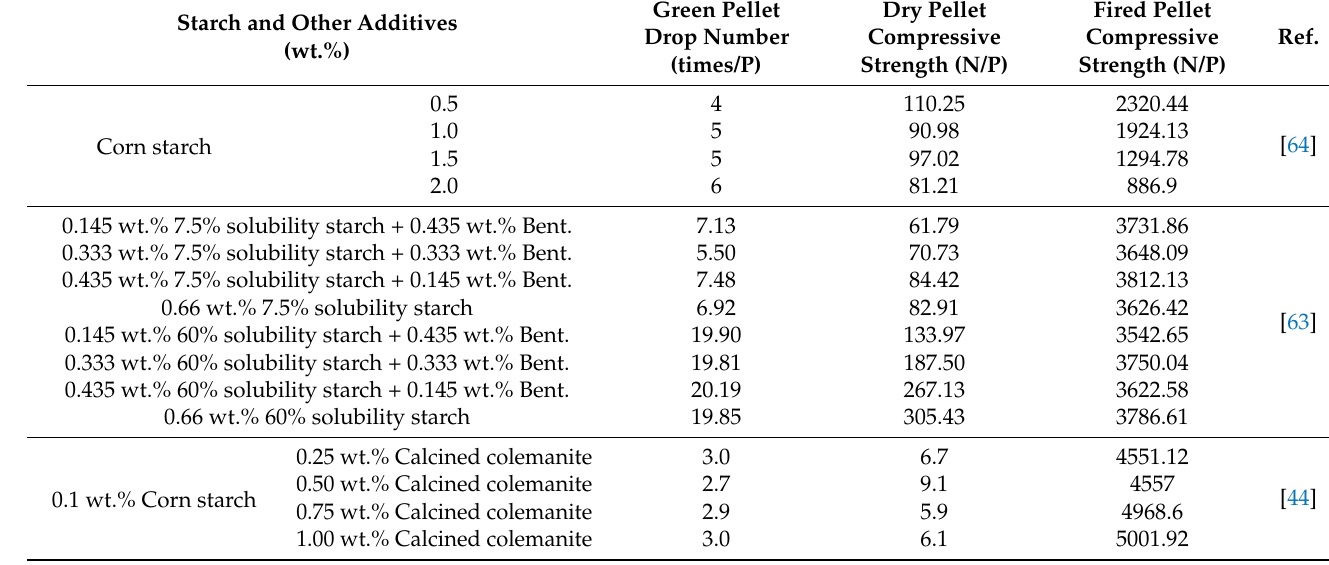
Table 2. The effect of starch with other additives on the performance of pellets. Starch and Other Additives